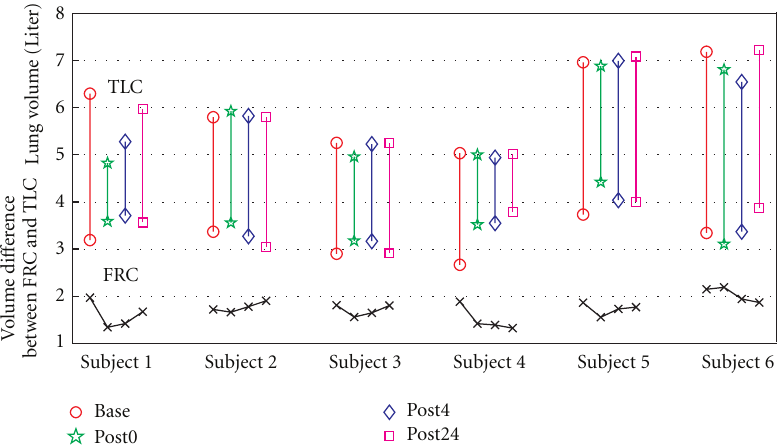
Figure 1: Lung volumes at FRC and TLC pressures, and the volume di ff erence between FRC and TLC scans in each phase for six subjects.